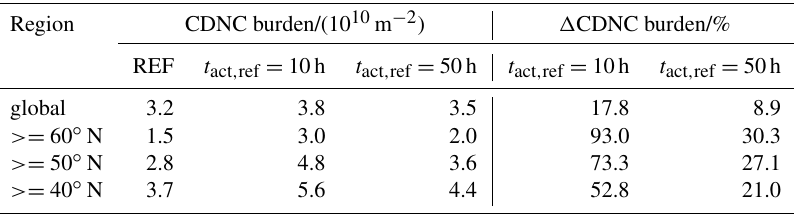
Table 3. CDNC mean burden of the three simulations globally averaged and averaged over different regions in the Northern Hemisphere as well as the change due to consideration of CCN-active BC and POM particles in the externally mixed Aitken mode after heterogeneous O 3